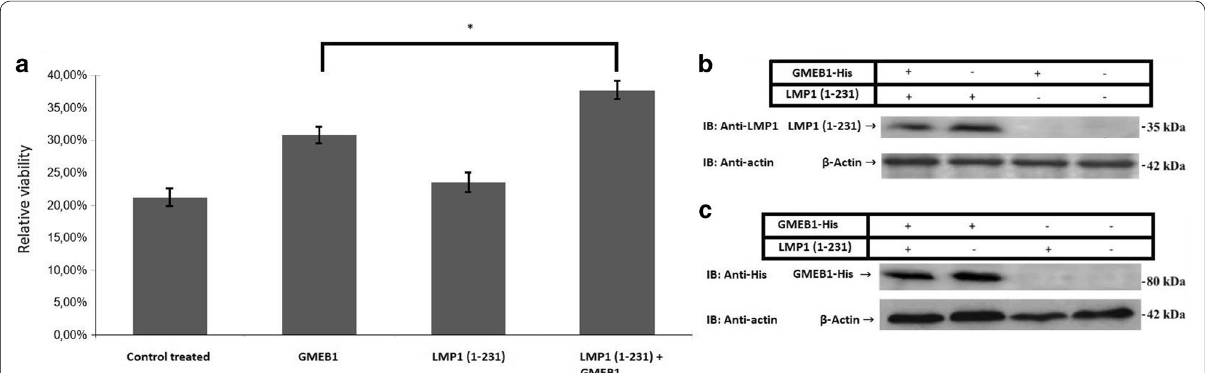
Fig. 5 The effect of LMP(1–231) on GMEB1-mediated antiapoptotic function. a Assessment of viability of HeLa cells, treated by CHX and TNFα, using MTT assay. LMP(1–231) (0.5 μg) expression vector and GMEB1-His (1 μg) were co-transfected to HeLa cells. 20 h postransfection, HeLa cells were treated with CHX and TNF-α for 24 h, in order to induce apoptosis. Viability is calculated as the ratio of O.D. sample/O.D. control untreated * 100. The data are presented as the mean standard error ( SEM) of three independent repetitions. Statistical evaluation of the differences between ± ± the values was performed by Student’s t-test. Statistically significant differences are indicated by brackets and an asterisk ( p < 0.05). b Immunoblot analysis. Total cell lysates from HeLa cells transfected with LMP(1–231) and GMEB1-His were analyzed by SDS-PAGE on an 8% gel. The detection of the indicated proteins was performed using the antibodies reported in “Methods” section. β-actin was used as a loading